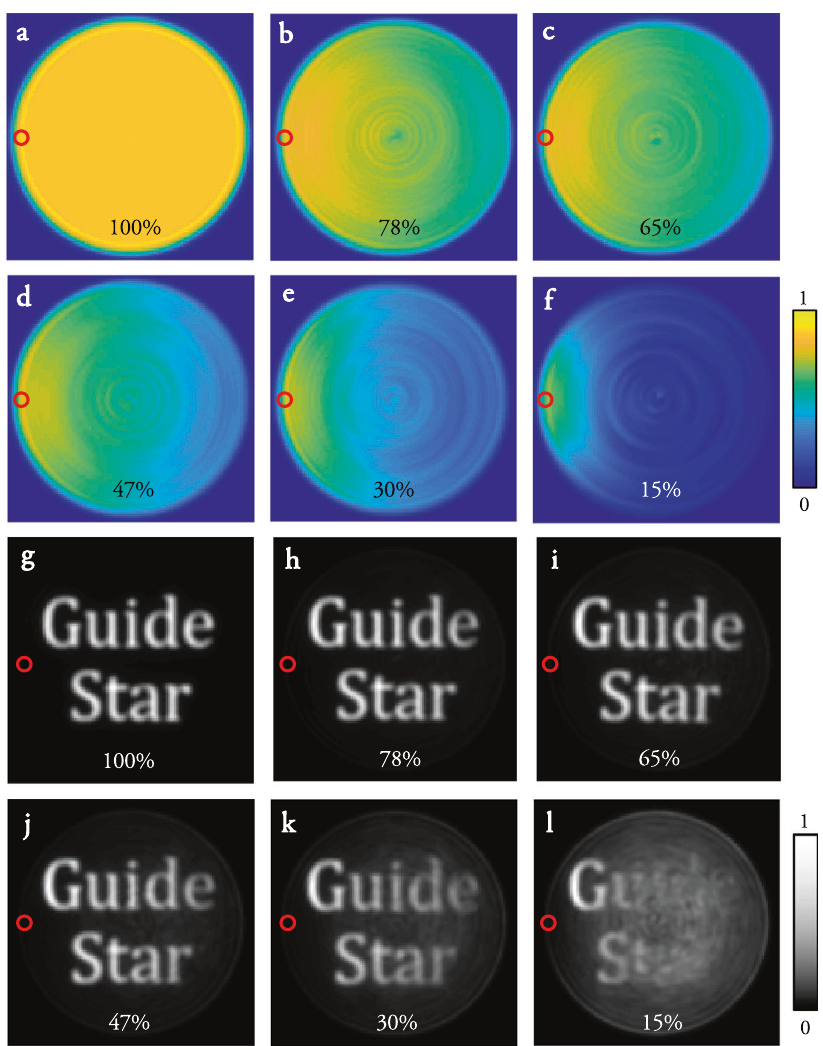
Fig. 3 The size and shape of the isoplanatic patch:. a – f Simulated maps of the power-ratio of points focussed to different regions of the distal facet through non-ideal fi bres with quasi-diagonal TM D . The scale-bar indicates the power-ratio across the distal facet. Higher values of the power-ratio indicate regions on the distal fi bre facet where spot scanning can be achieved with greater contrast, leading to higher fi delity imaging. We see that the isoplanatic patch gradually shrinks around the location of the guide-star (marked by a red circle). Foci are created using ATM D 0 calculated from u gs using Eq. (7). p d , the power on the diagonal of D , decreases from ( a ) to ( f ) and is given at bottom of each panel. g – l Simulations of scanning imaging capabilities in each case. The scale-bar indicates the relative intensity of the